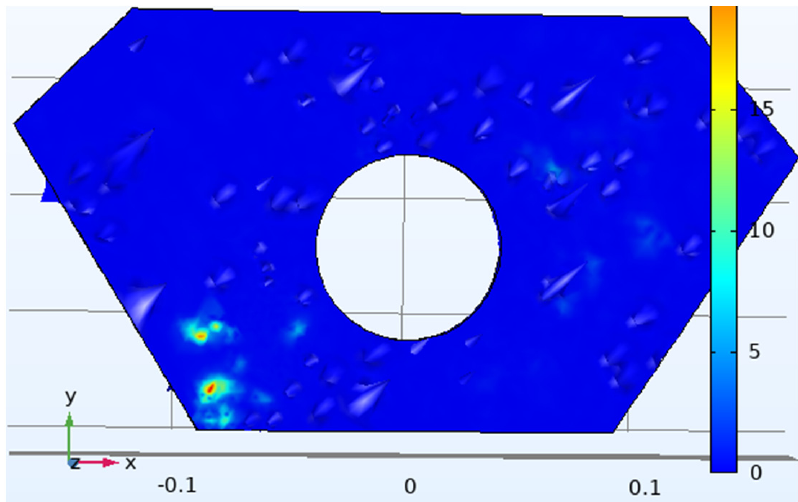
Figure 9. Predicting the outlook of the Comsol armor in the Johnson-Cook model.